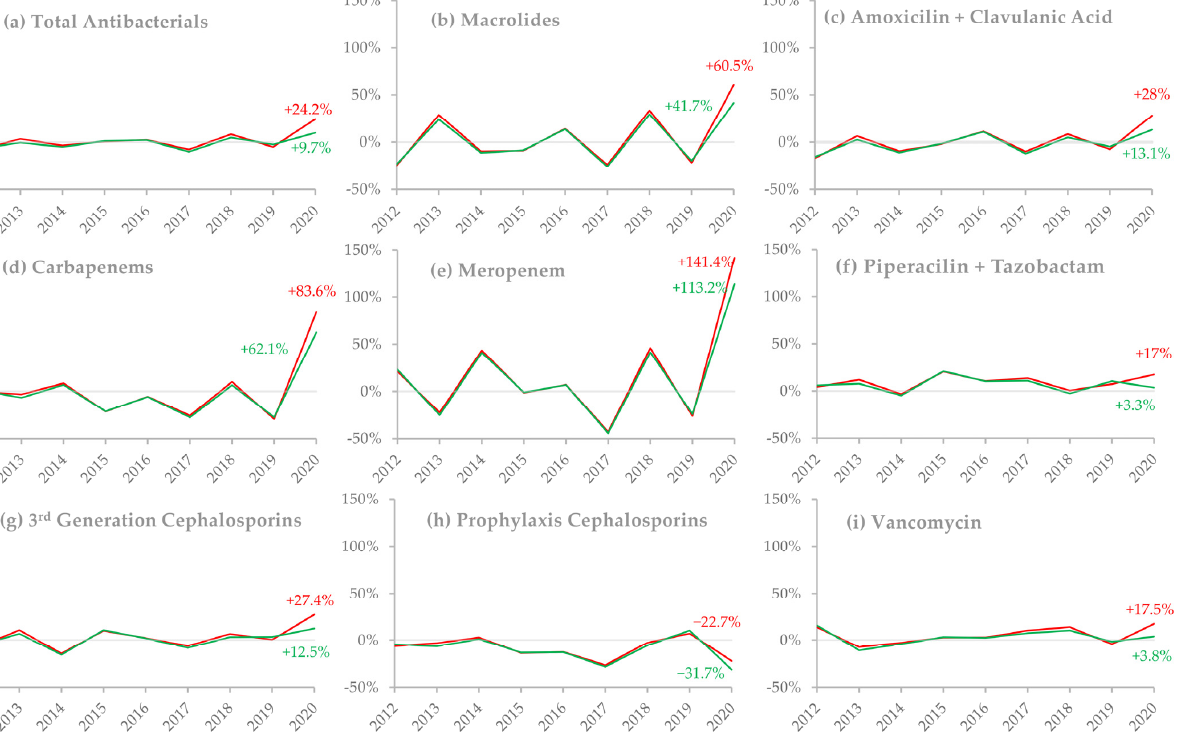
Figure 2. Annual percentage changes (APCs) in antimicrobial consumption between 2011 and 2020, stratified by different consumption indicators and drug groups. March–May DDD/100 discharges are represented by the red line, and March–May DDD/100 patient-days by the green line. Values for the 2020 annual percentage change are shown within the graphs. ( a ) Total antibacterials; ( b ) macrolides; ( c ) amoxicillin/clavulanic acid; ( d ) carbapenems (ertapenem/imipenem/meropenem); ( e ) meropenem; ( f ) piperacillin/tazobactam; ( g ) third-generation cephalosporins (ceftriaxone/ceftazidime/cefotaxime); ( h ) prophylaxis cephalosporins (cefazolin/cefoxitin); ( i ) vancomycin.